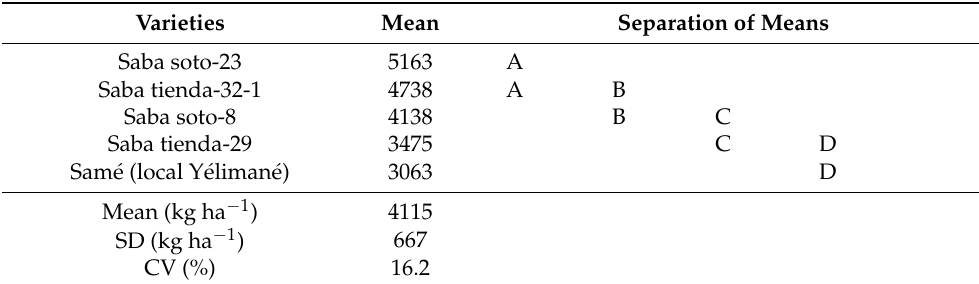
Table 6. Average sorghum grain yield (kg ha − 1 ) across sites of flood recession farming for the five tested varieties in Yaguine, Gory, and Foungou in the 2015/2016 cropping season. Varieties Mean Separation of Means Saba soto-23 1608 A Saba soto-8 1475 A Saba tienda-29 1458 A Saba tienda-32-1 1456 A Sam é (local Y é liman é ) 979 B Mean (kg ha − 1 ) 1395 SD (kg ha − 1 ) 165 CV (%) 11.8 A, B: values in the Sam é column with different letters are significantly different at p = 0.05. SD: standard deviation; CV: coefficient of variation.